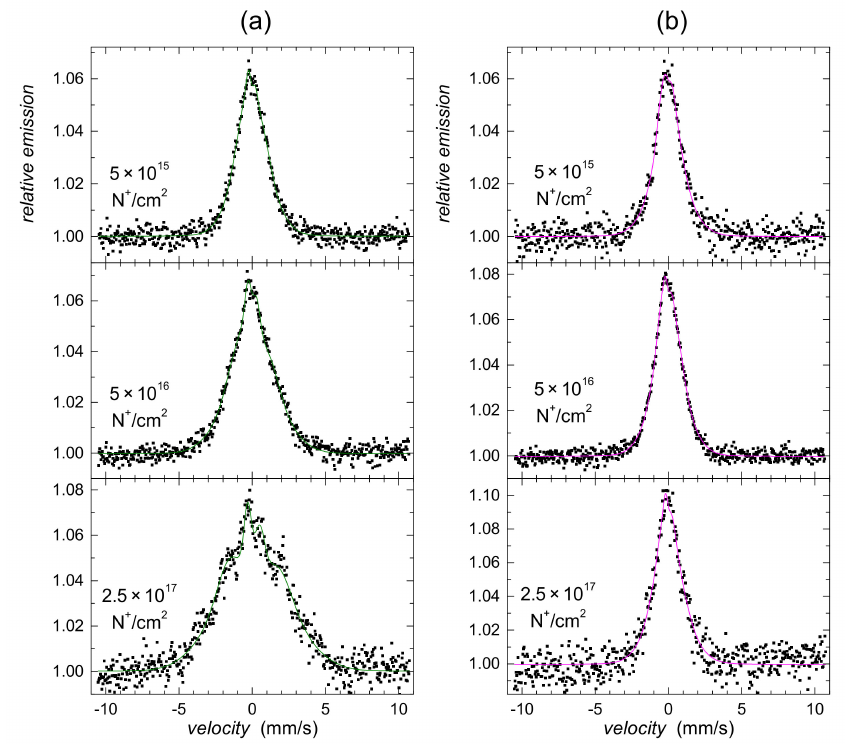
Figure 16. CXMS spectra of 57 Fe 75 Mo 8 Cu 1 B 16 amorphous metallic ribbons recorded from its: ( a ) air side (dark green); ( b ) wheel side (magenta) of the ribbons after irradiation by 130 keV N + ions with the indicated